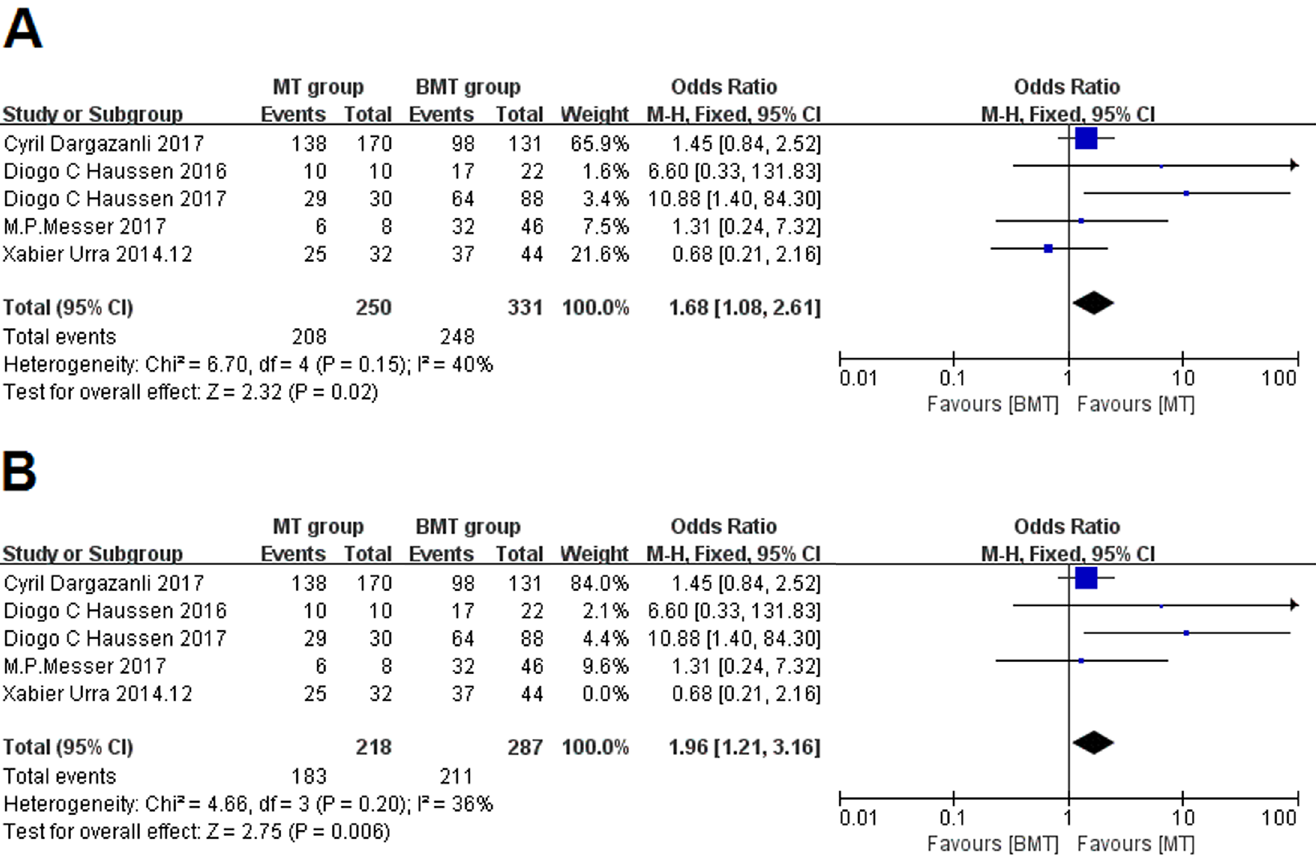
Fig 2. Forest plots of good outcomes. A: Forest plots showing the odds ratios of good outcomes (90-day mRS of 0–2) in patients treated with mechanical thrombectomy (MT) vs. those treated with best medical treatment (BMT). B: Forest plots showing the odds ratios of good outcomes (90-day mRS of 0–2) in patients treated with MT vs. those treated with BMT excluding the study by Urra X et al.